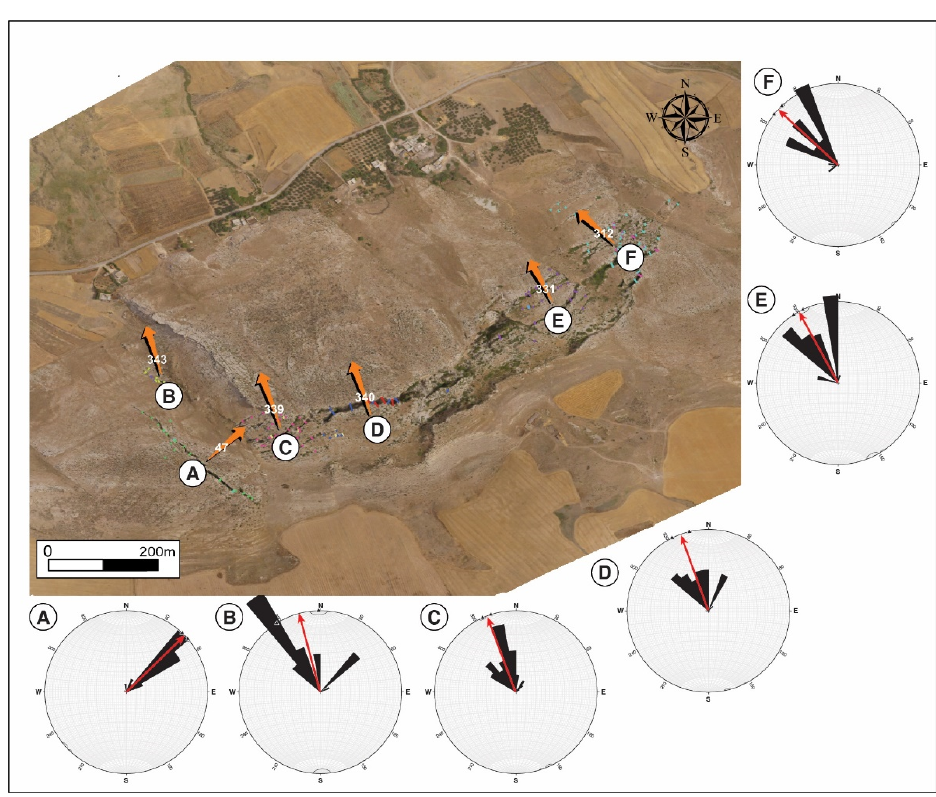
Figure 12. Rose diagrams and orientation of the mean movement vectors for each sector of the Chgega landslide obtained through analysis of the open joints.